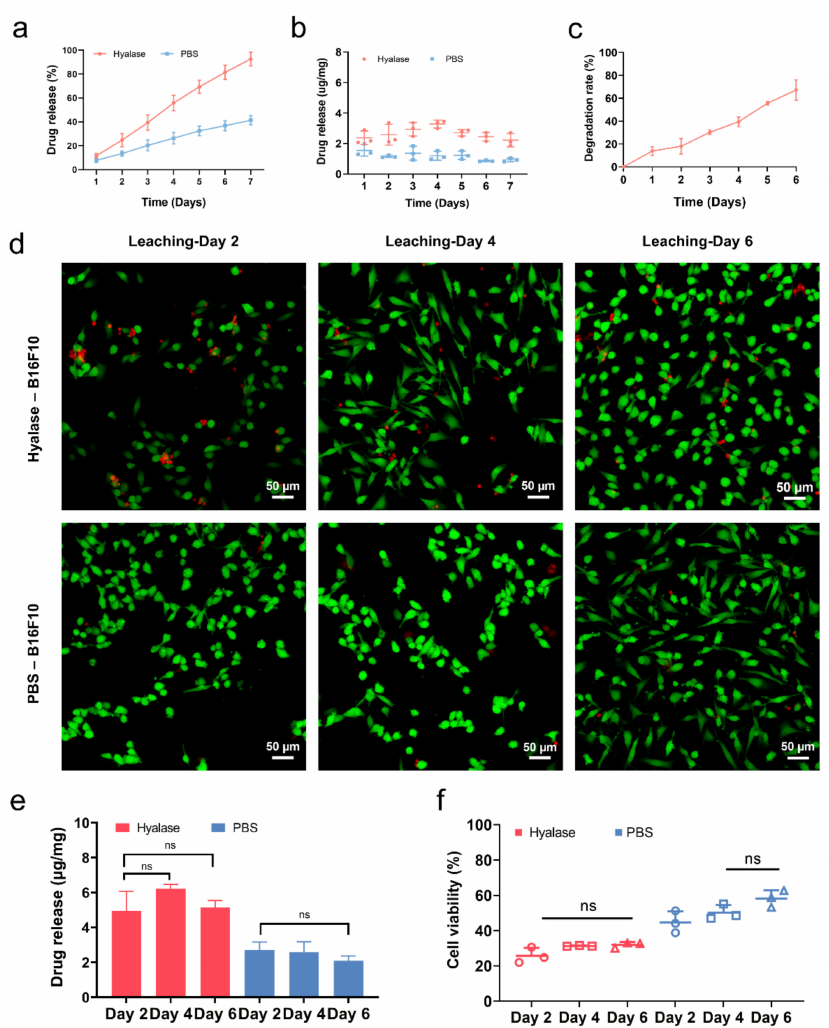
Figure 5. ( a ) The cumulative drug release profile of HA-DOX in PBS/Hyalase. ( b ) The drug release amount of DOX per day. ( c ) In vitro degradation. ( d ) Live/dead staining of B16F10 cells cultured with every two days of leaching. ( e ) Drug release profile of HA-DOX for every two days. ( f ) CCK-8 assays of B16F10 cells cultured with every two days of leaching (ns indicates no